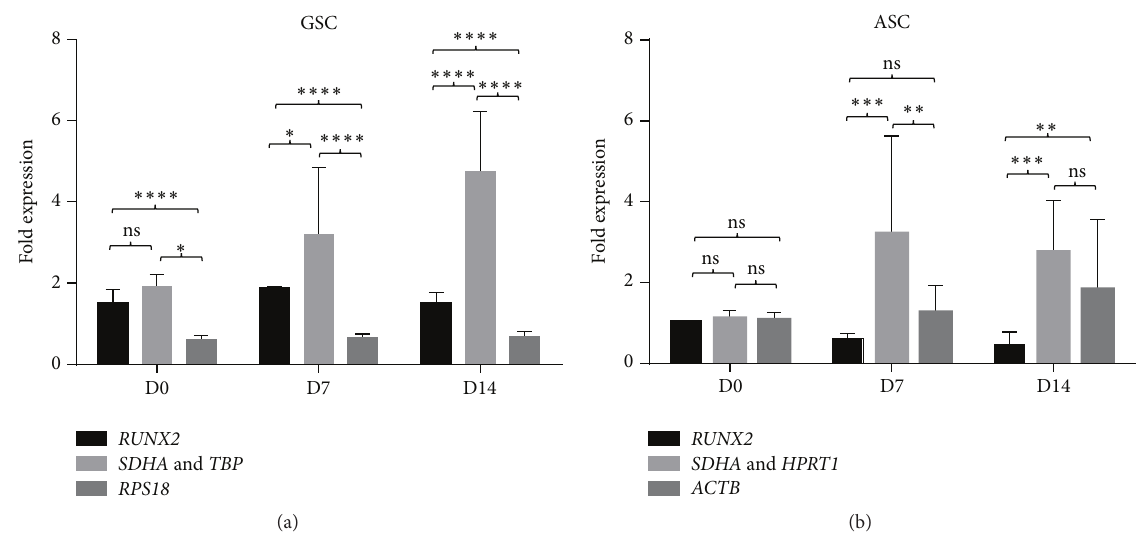
Figure 8: Effect of the choice of stable HKGs in the study of dGSC ( 𝑛 = 6 ) (a) and ASC ( 𝑛 = 6 ) (b). The normalization of fold expression of an osteogenic marker, RUNX2 , was performed on D0, D7, and D14. As calibrators: for dGSCs: TBP / SDHA the most stable HKGs and RPS18 the least stable one. For ASCs: SDHA / HPRT1 the most stable HKGs and ACTB the least stable one. 𝑝 values have been obtained with unpaired 𝑡 -test. ∗∗∗∗ 𝑝 ≤ 0.0001 , ∗∗∗ 𝑝 ≤ 0.001 , and ∗∗ 𝑝 ≤ 0.01 and “ns” stands for 𝑝 ≥ 0.05